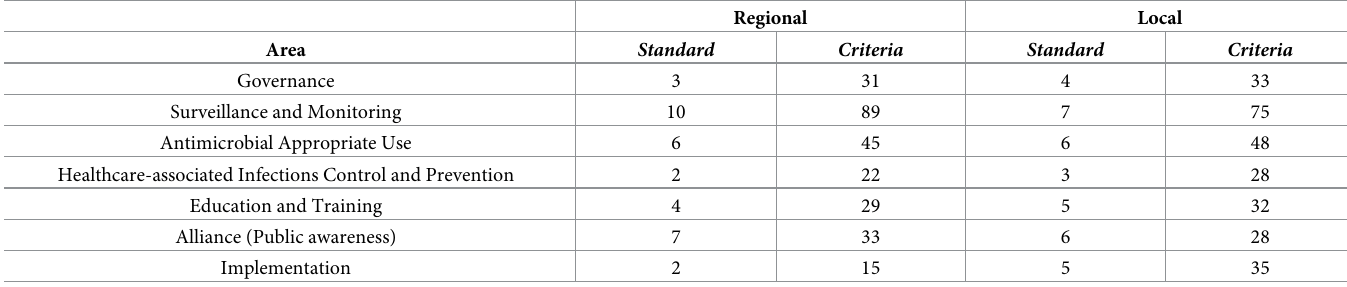
Table 1. Number of standards and criteria for each Area in the